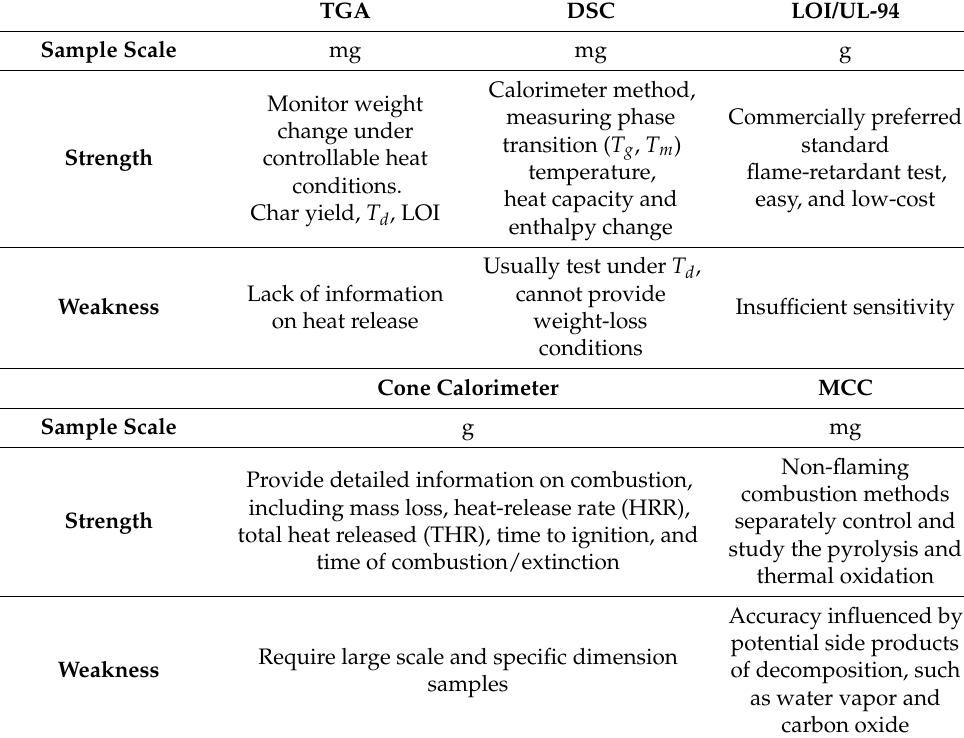
Table 2. Comparison of commonly used flame-retardancy techniques.